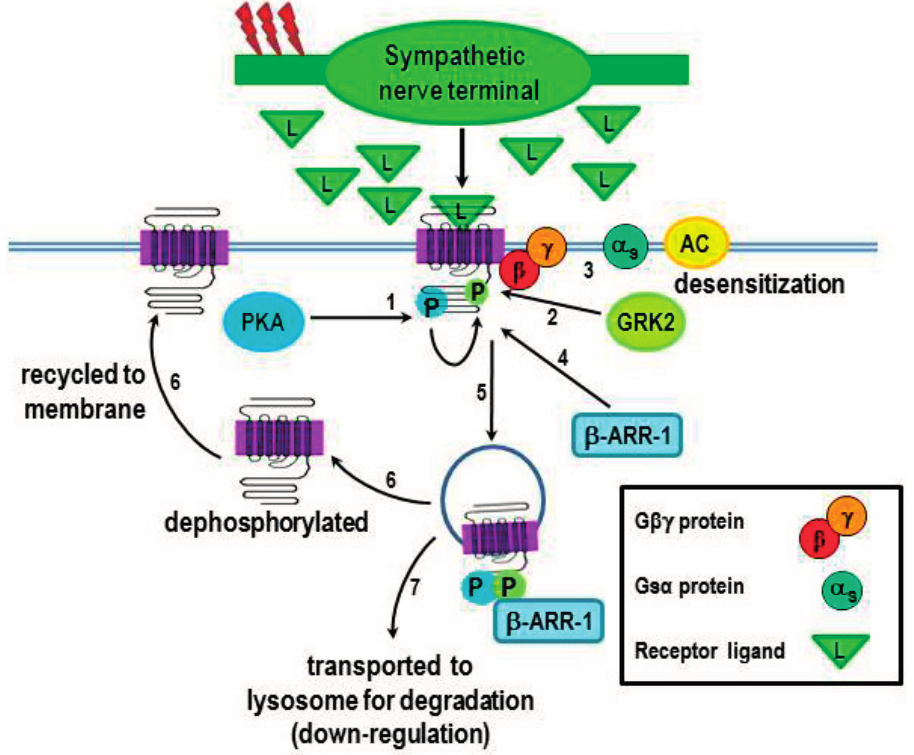
Figure 3. Receptor responsiveness to β 2 -AR ligands is regulated by protein kinases that phosphorylate the receptor. PKA that is activated after β 2 -AR activation by ligand (L) subsequently phosphorylates the receptor (#1), which uncouples G α s from the G βγ subunit, this results in an uncoupling of G α s from the receptor (#3), thus terminating receptor signaling. Phosphorylation of the receptor by PKA also facilitates receptor phosphorylation by GRK2 (#2), which further drives receptor desensitization (#3). GRK2 recruits β -arrestin-1 to the receptor (#4), a step that leads to receptor internalization (#5). The internalized β 2 -AR is then transported to lysosomes for degradation (#7), receptor down-regulation or dephosphorylation and recycled to the cell membrane (#5–6). Chronic stimulation of the receptor or high ligand concentrations promote the transport of the receptor to lysosomes for degradation, resulting in receptor down-regulation. Red lightning bolts indicate increased sympathetic nerve